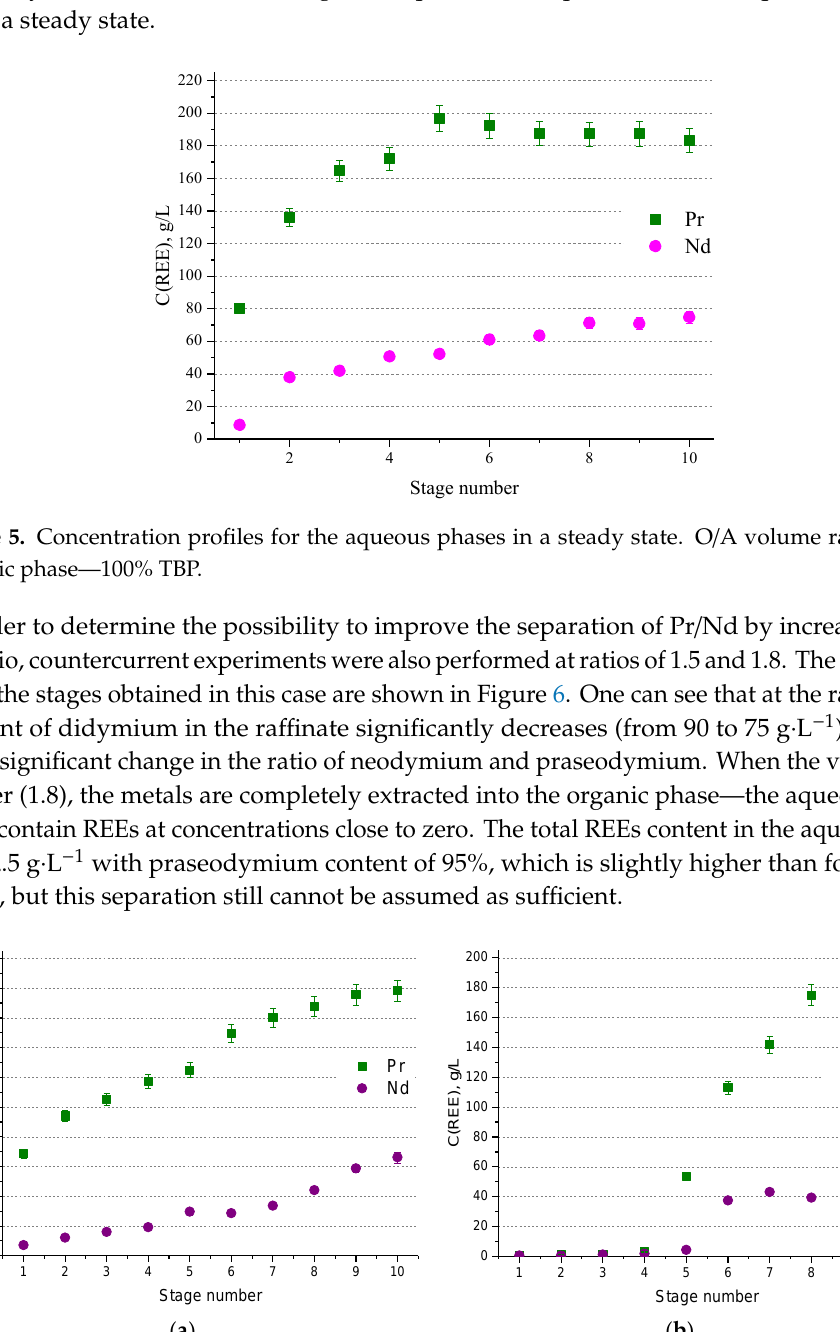
Figure 6. Concentration profiles for the aqueous phases in a steady state. O/A volume ratios = 1.5:1; ( a ) 1.8:1, ( b ) organic phase — 100% TBP.